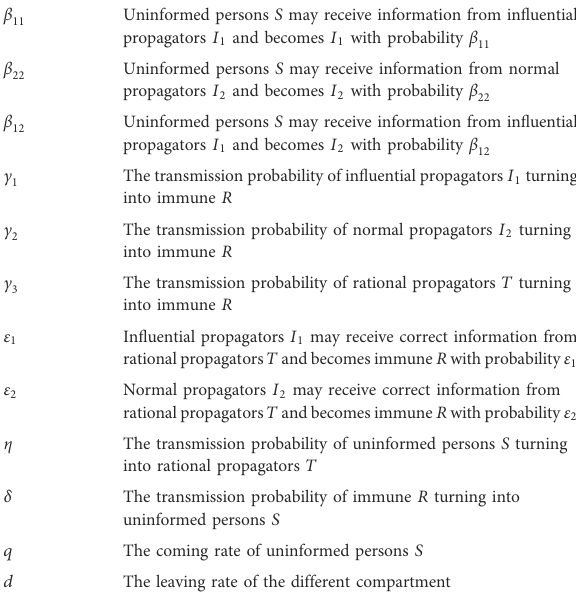
TABLE 1 Parameters de fi ning the L-SITR model. Parameter